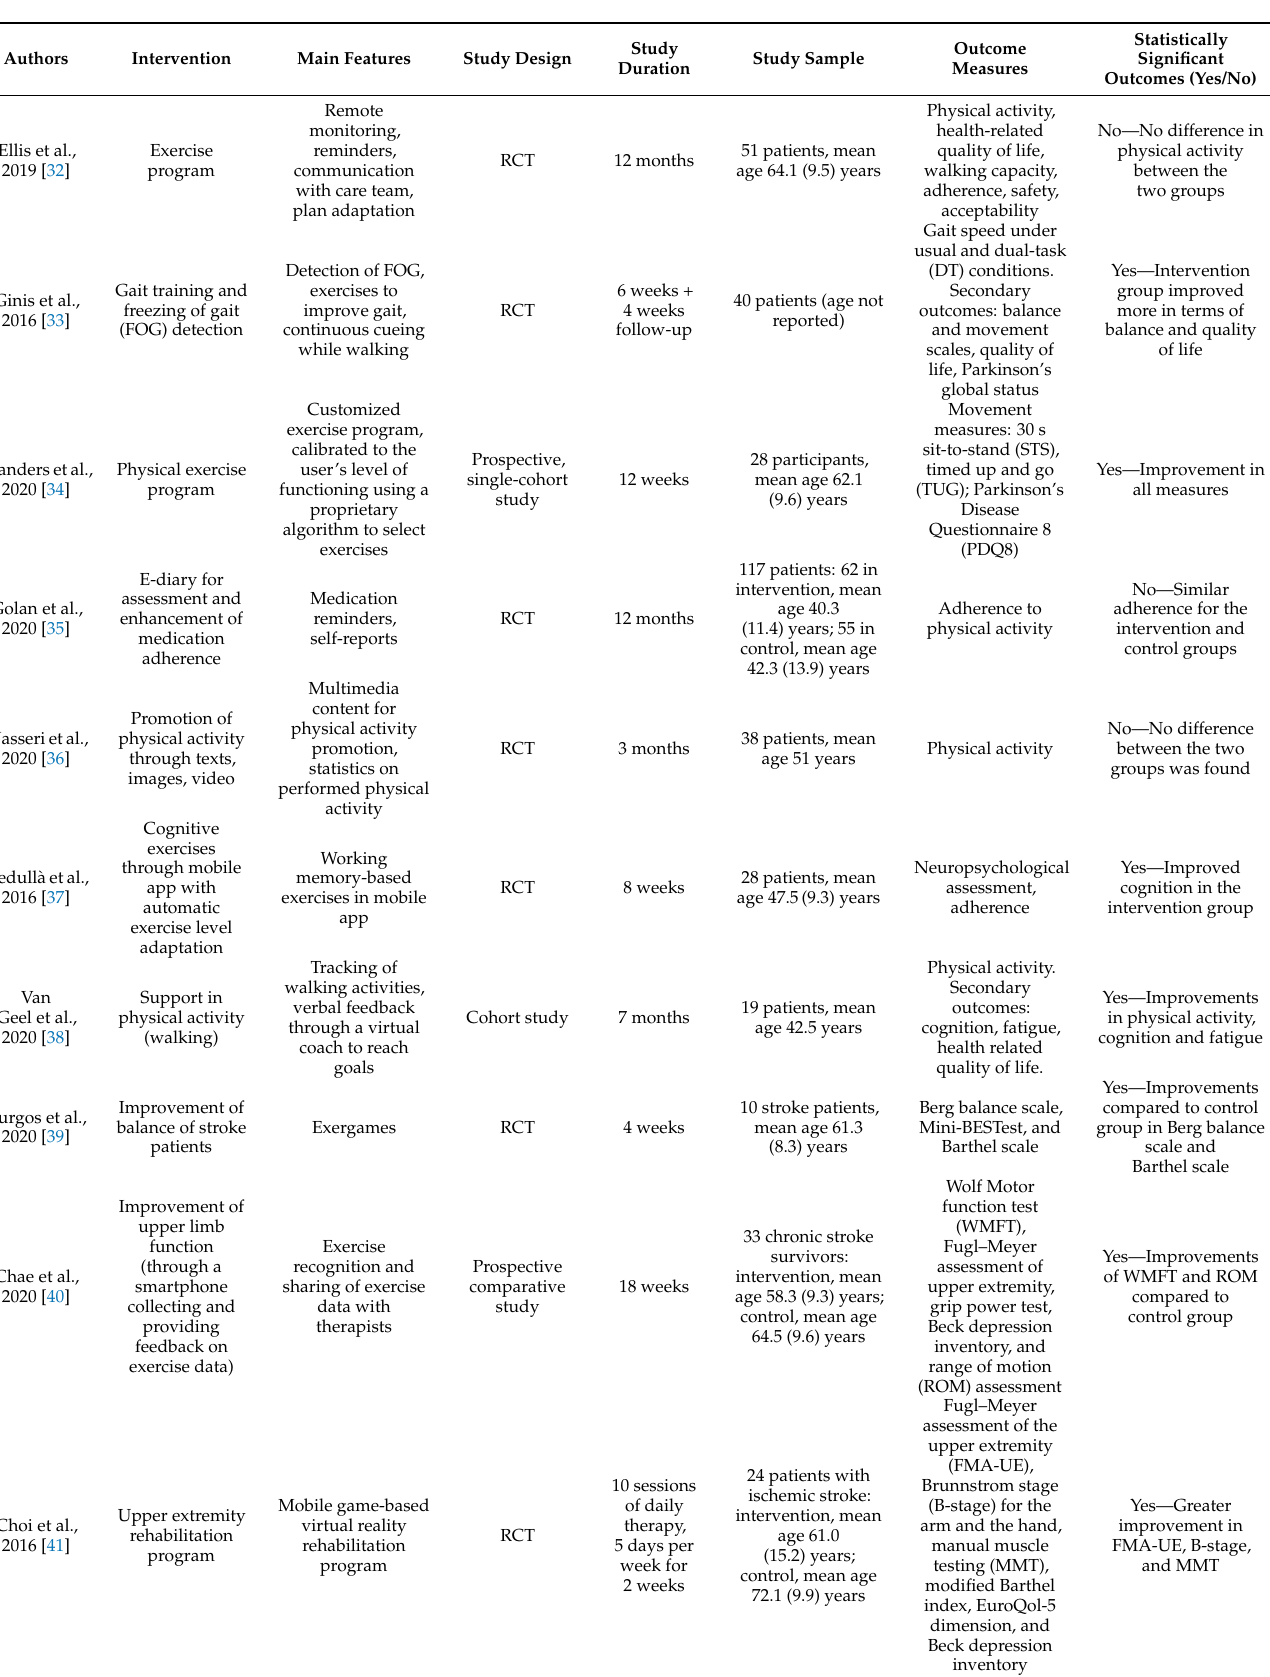
Table 3. Characteristics of included